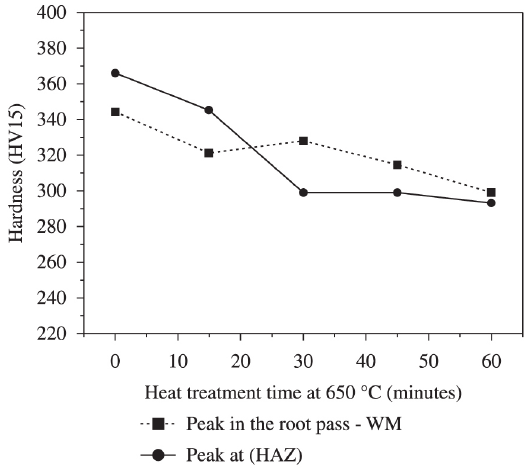
Figure 5. Variation of peak hardness with time of PWHT (650 o C).